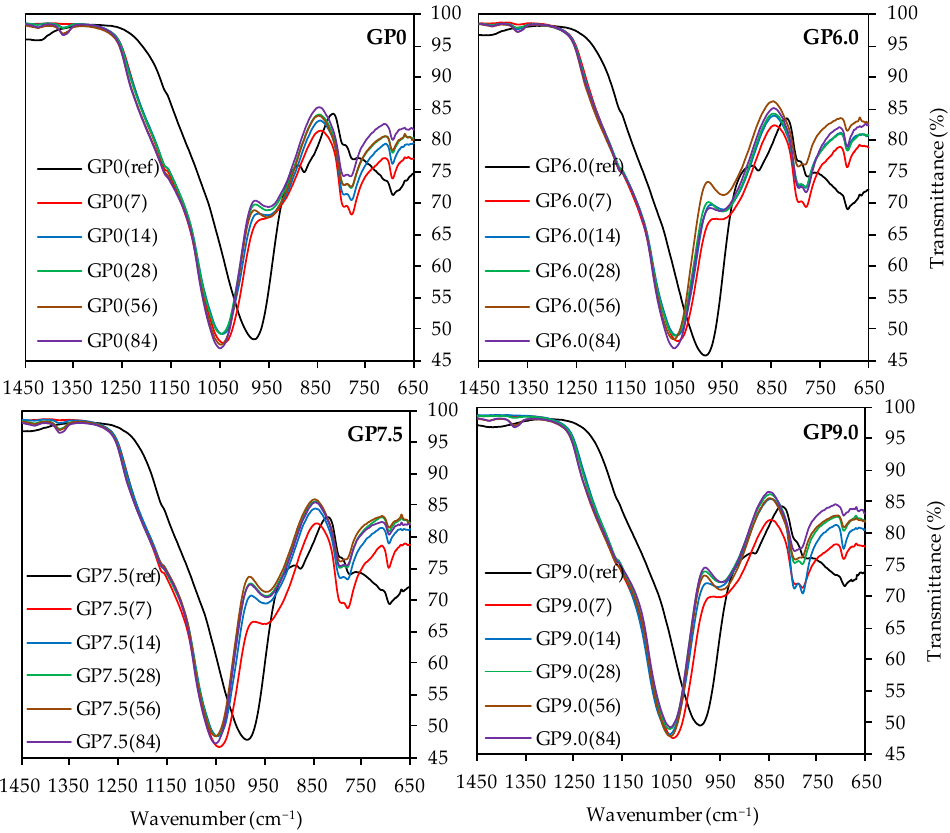
Figure 11. FTIR-spectra of geopolymers GP0, GP6.0, GP7.5 and GP9.0 before (ref) and after exposure to sulfuric acid (7, 14, 28, 56, 84).